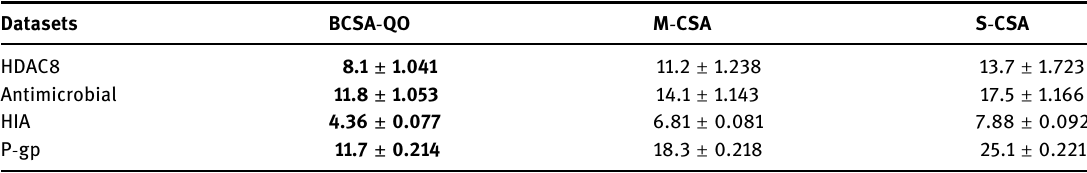
Table 2: The averaged selected features obtained by the used methods ( testing or training )